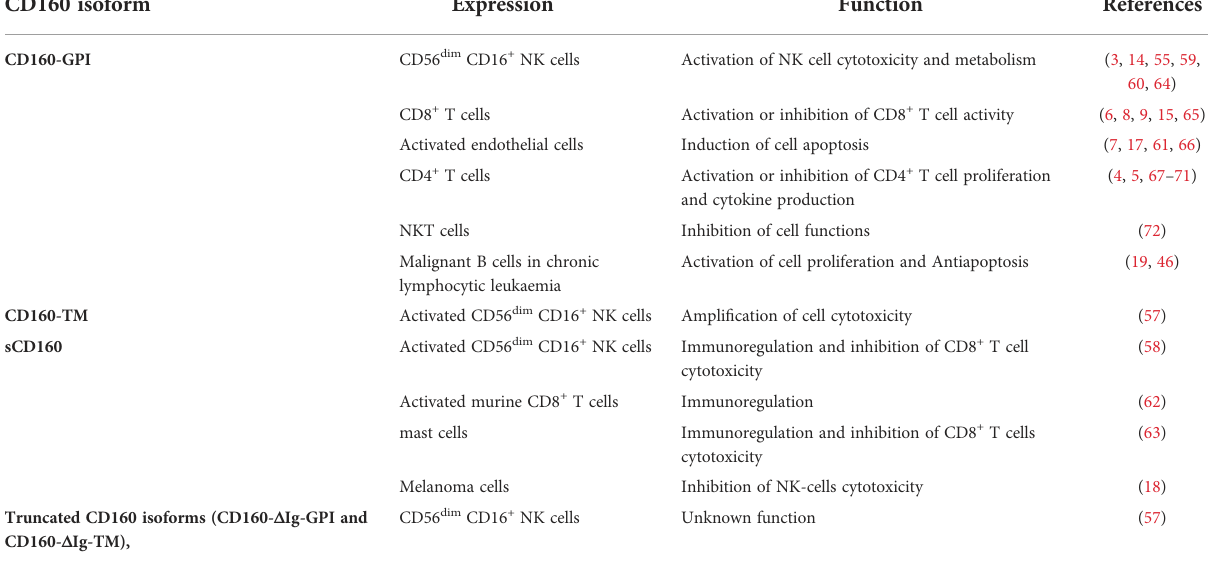
TABLE 1 Cell expression and functions of CD160 isoforms. CD160 isoform